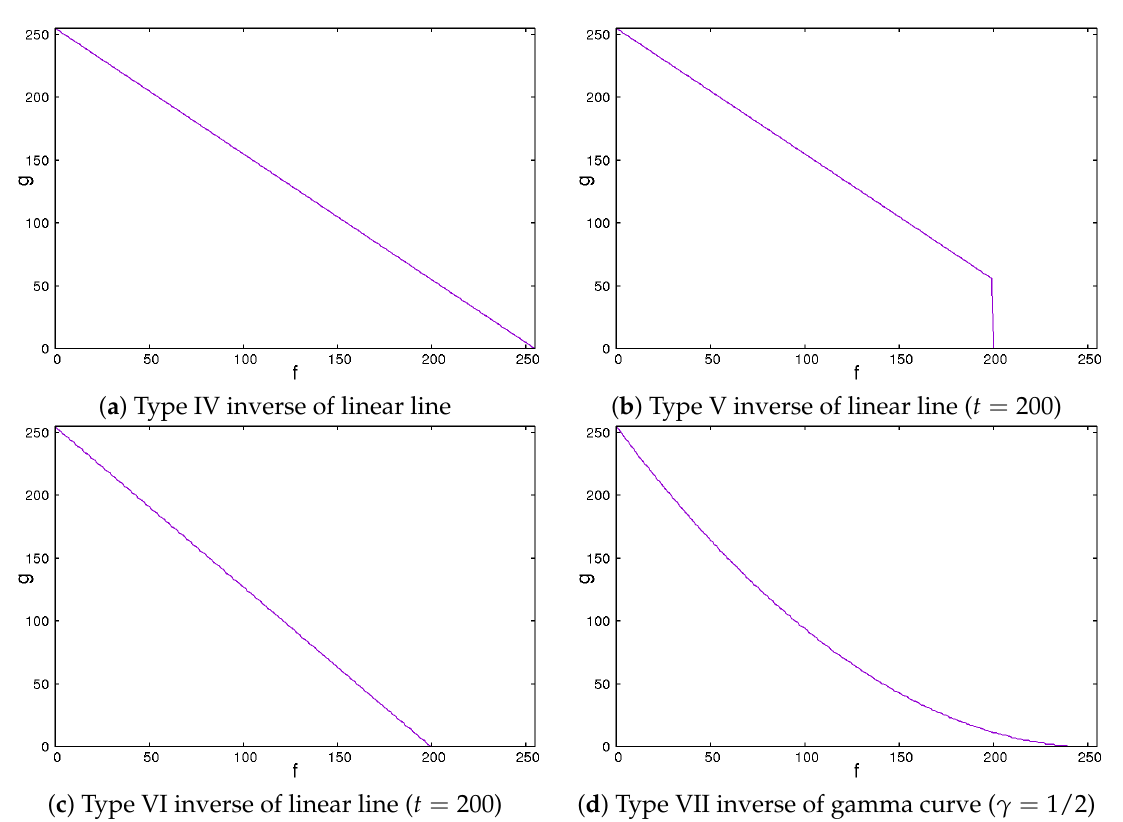
Figure 5. Inverse of tone